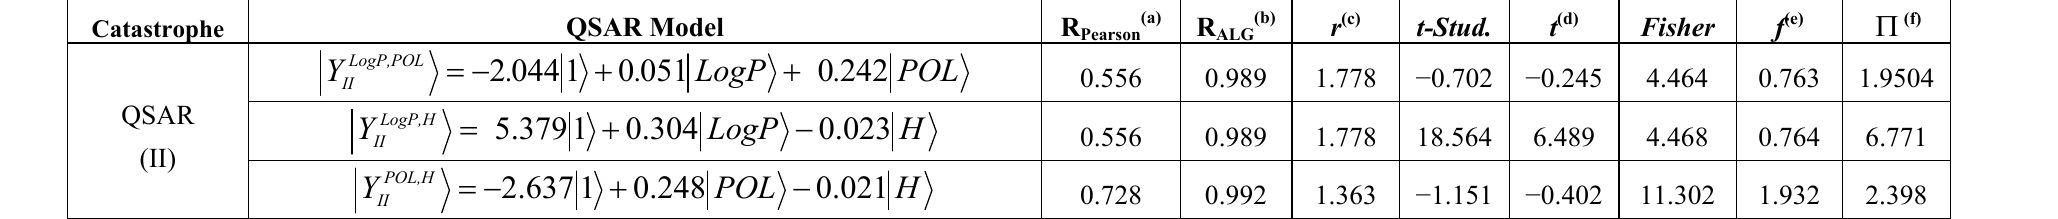
Table 6. Correlation equations for the Group-II models of Table 3 and the molecular structures and data of Table 4.